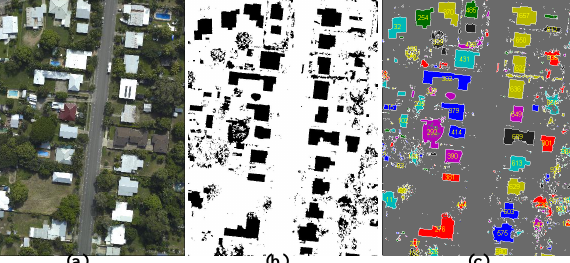
Figure 2. Sample data: (a) Aitkenvale multispectral image, (b) Primary building mask, and (c) CCA output with initial boundary and